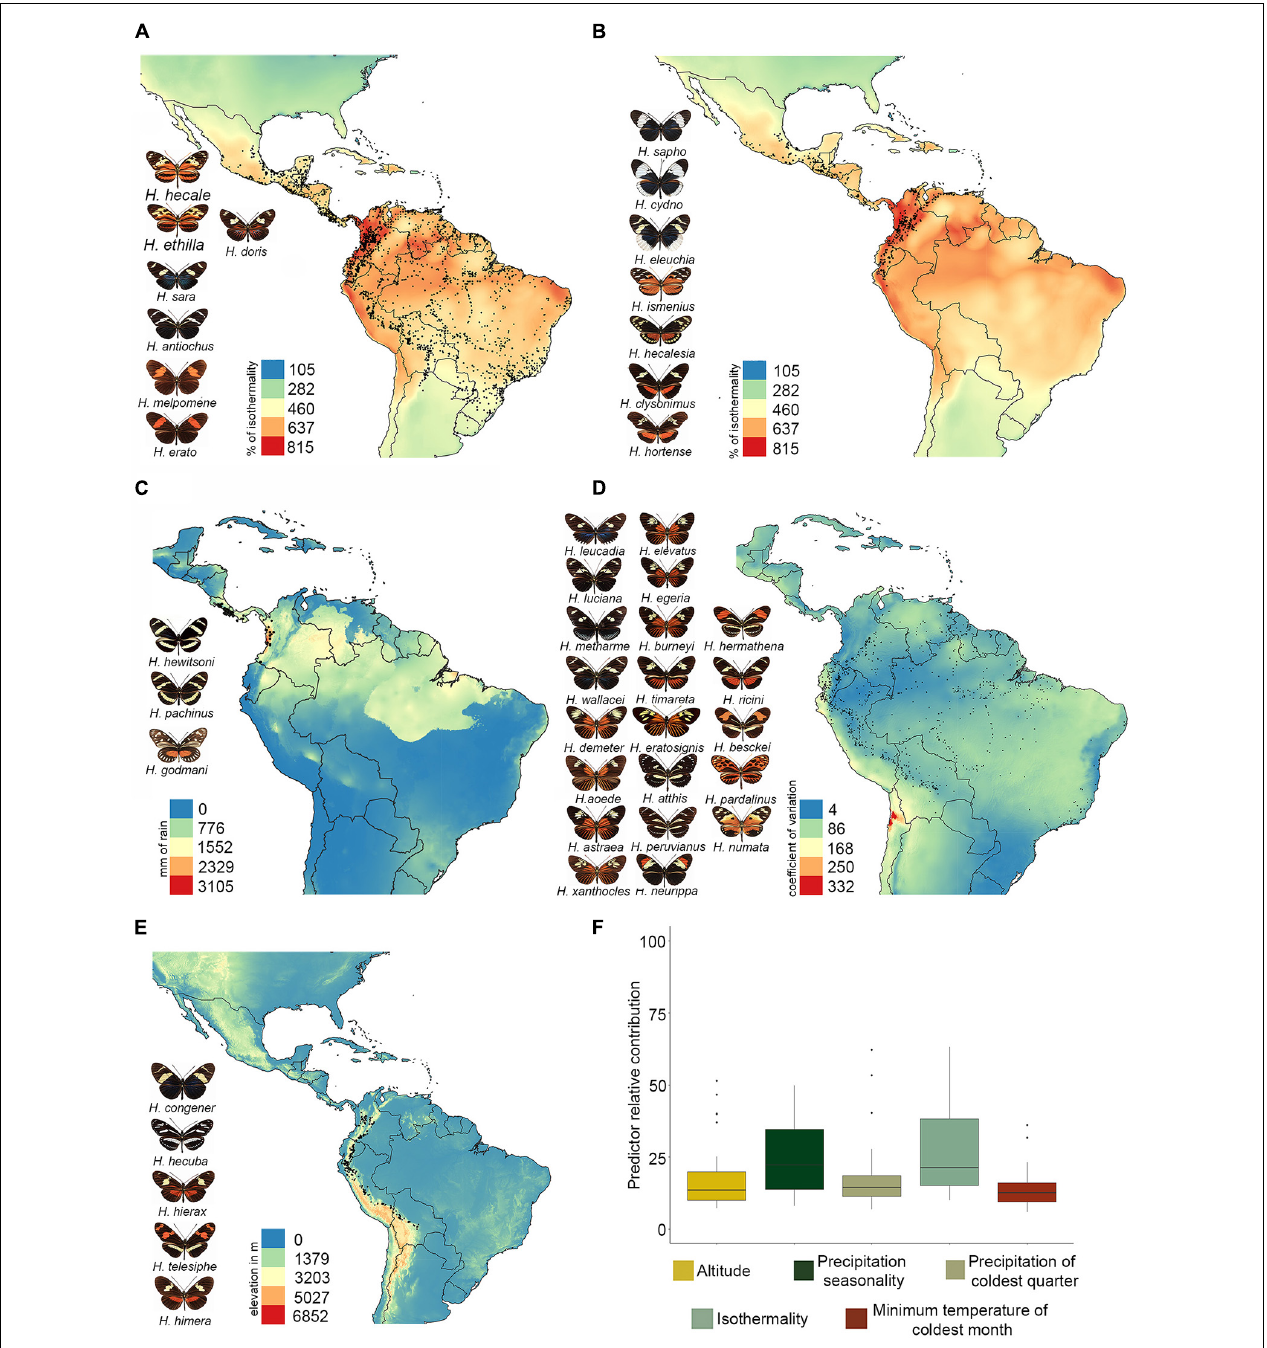
FIGURE 1 | Distribution patterns of Heliconius species based on environmental variables. (A) Species with wide distribution (explained by isothermality); (B) species with trans -Andean distribution (explained by isothermality); (C) species distributed in the biogeographic Choco + Costa Rica (explained by precipitation of coldest quarter); (D) species distributed in the cis -Andes + Pacific of Ecuador (explained by precipitation seasonality); (E) species distributed in highlands of the Andes (explained by altitude); (F) relative importance of environmental variables receiver operating characteristic (ROC) that are predictors of diversity in Heliconius . Color scale in panels (A–E) indicates the variable gradient. Distribution maps for each of the species can be found at: